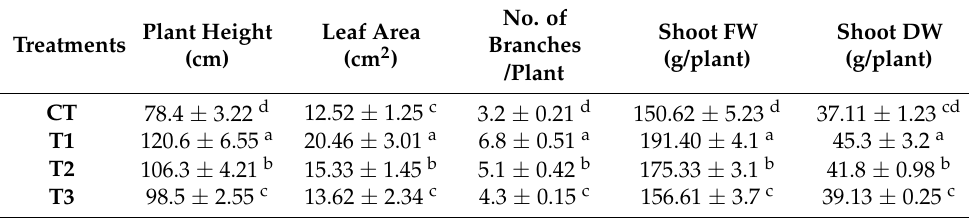
Table 1. Impacts of diverse iron sources (nano, chelate, and sulfate), as foliar spray on some growth attributes of Vicia faba